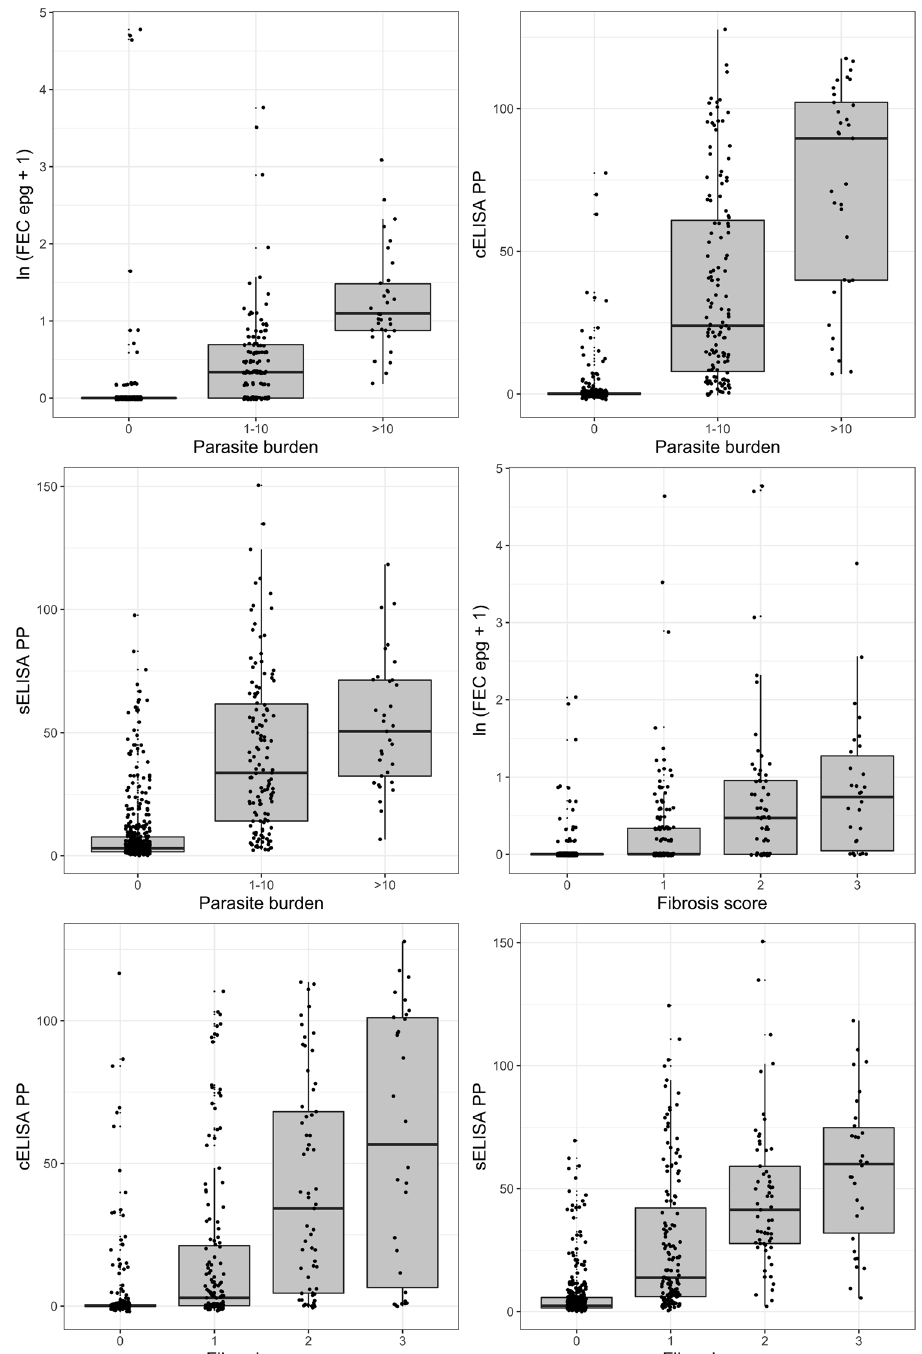
Figure 8. Relationship between diagnostic tests and severity of disease. Plots show the raw results of each diagnostic test vs. parasite burden (left) and fibrosis score (right). There are positive trends between test results and increasing parasite burden and fibrosis scores, but there is great variability in actual